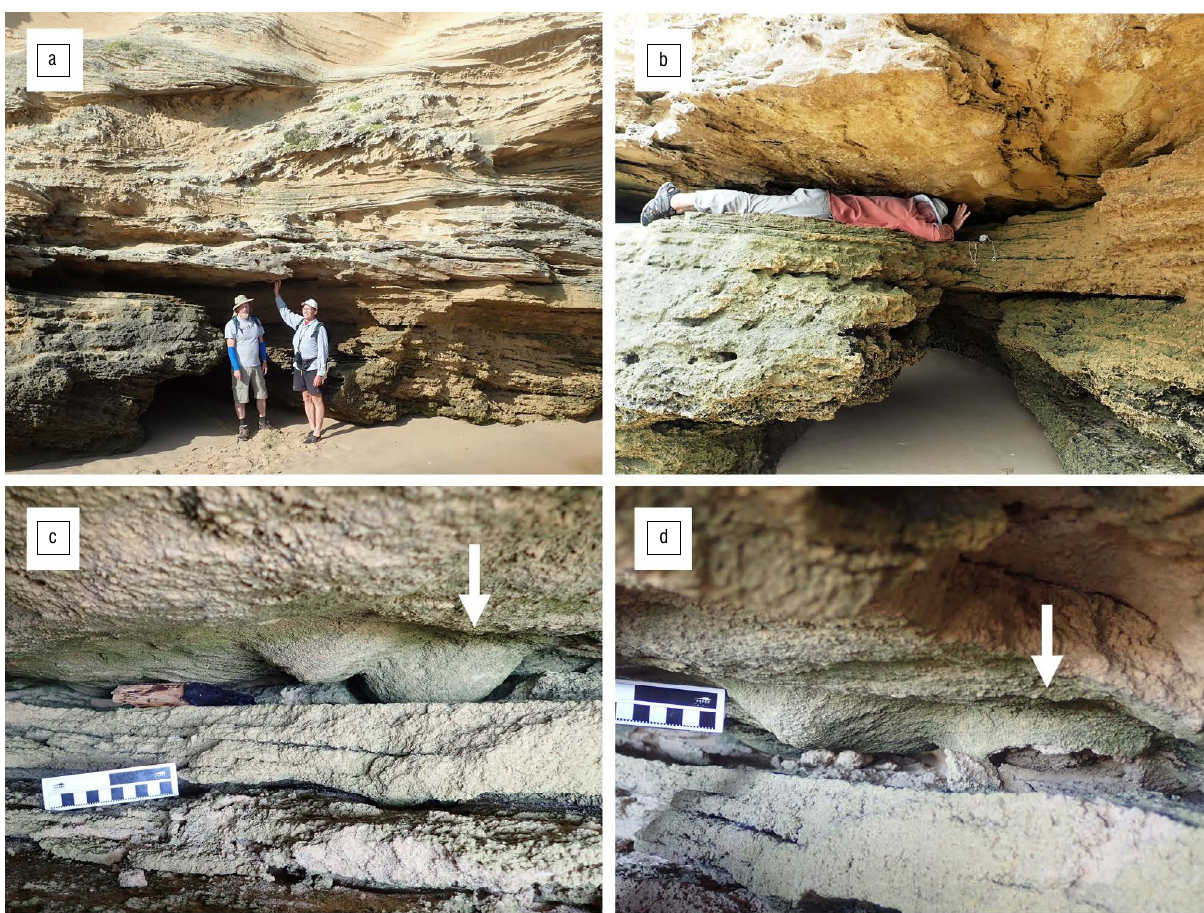
(a) Two figures at the entrance to the small cave that contains Site 1. (b) Distance between floor and ceiling is as little as 75 cm in the deeper portion of the cave. (c and d) Comparison views of Track A (indicated by arrows) before and after storm surge events – the track to the left of Track A is Track E; scale bars = 10